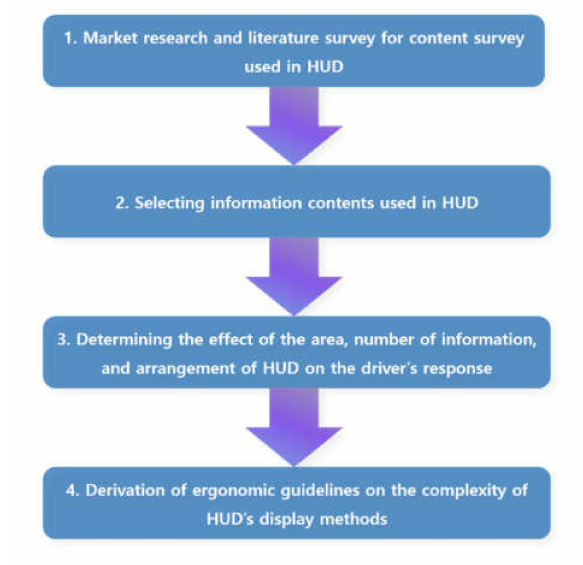
Figure 1. Research flow.